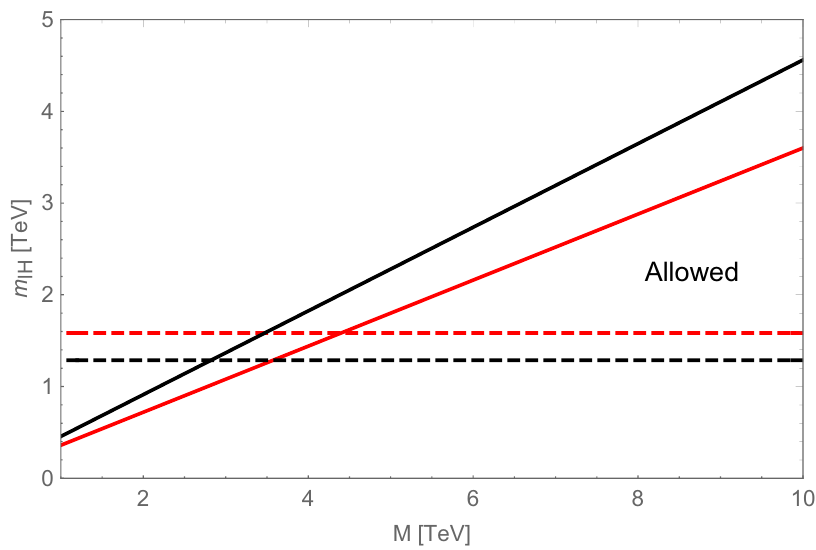
Figure 4 . Allowed mass region for the mirror lepton mass m ‘H versus the quasi-Dirac neutrino mass M for di(cid:11)erent values of the next physics scale f . Solid lines are (cid:12)xed by the upper bound of 0.03 on the mixing between SM and heavy neutrinos for f = 1 : 5 TeV (red) and 1.9 TeV (black). While dashed lines delimit the regions excluded by the non-observation of mirror